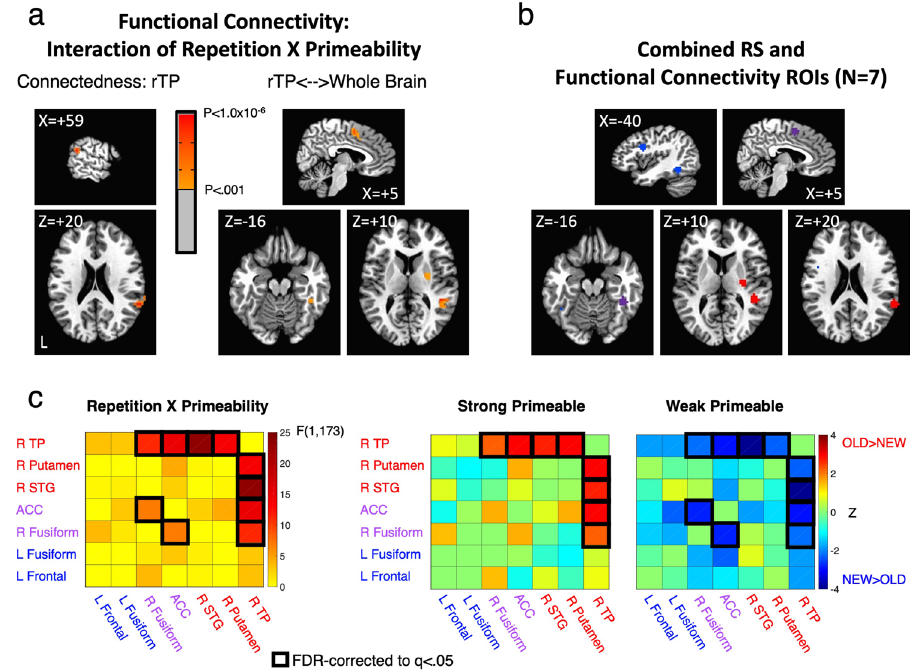
Fig. 6 Functional connectivity shows interaction between Primeability and Repetition. a A right temporoparietal (R TP) region exhibited an interaction in whole-brain connectedness between Repetition and Primeability, similar to that seen in the behavioral priming results ( P < 0.001, corrected to P < 0.025). When used as a seed, R TP jointly exhibited this interaction with the anterior cingulate (ACC), right putamen, right STG, and the right fusiform gyrus. b Regions showing a Repetition × Primeability interaction were combined with regions showing repetition suppression in both Overt and Covert Naming Tasks. c Region-by-region functional connectivity interactions of Repetition × Primeability are shown for all 7 regions (left panel). FDR-corrected effects are indicated by black boxes ( P < 0.01, q < 0.05). Region-by-region comparisons of OLD versus NEW functional connectivity are shown for Strong and Weak Primeable conditions separately in the right panels. Warm colors (red) indicate OLD > NEW and cool colors (blue) indicate NEW > OLD. FDR-corrected effects ( P < 0.0286, q < 0.05) were calculated among all region-by-region combinations showing a signi fi cant Repetition × Primeability interaction, indicated by black squares. Statistics are based on N = 60 independent participants, organized into a factorial design with Task (Overt, Covert Naming) as a between-participant variable. For related content in SI, see Supplementary Fig. 2 and Supplementary Table